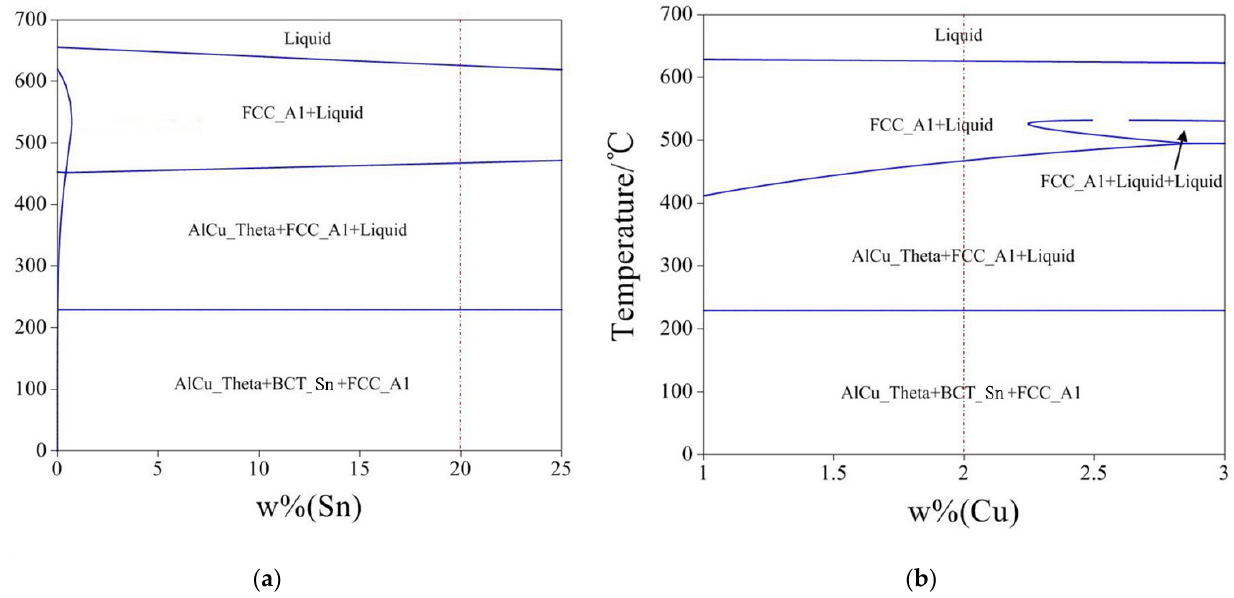
Figure 1. The equilibrium phase diagram of the AlSn20Cu alloy calculated by PANDAT: ( a ) the phase transition with increasing Sn content in Al–2Cu matrix, ( b ) the phase transition with increasing Cu content in Al–20Sn matrix.